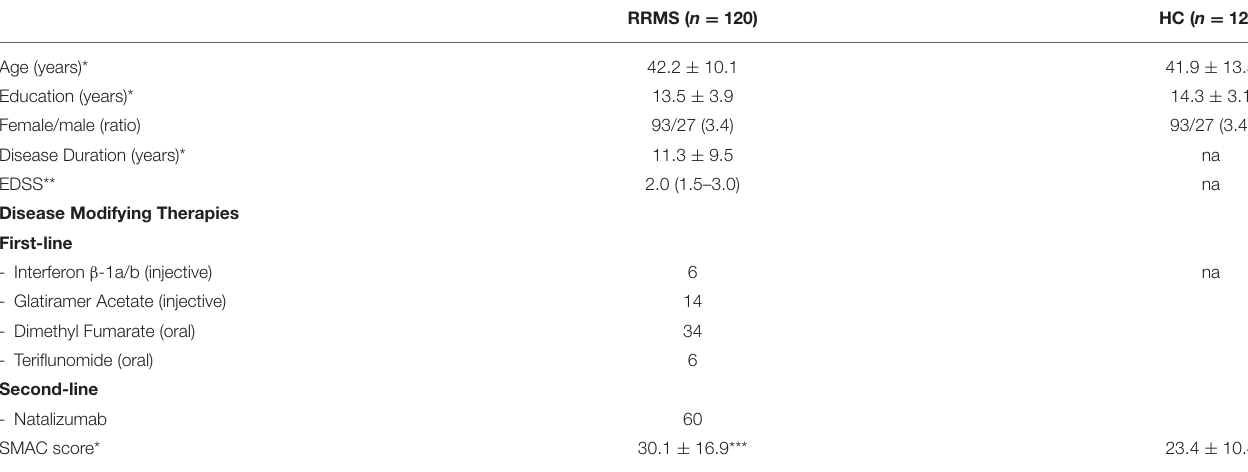
TABLE 1 | Demographic and clinical features of the 120 RRMS included in the study and demographic features of the